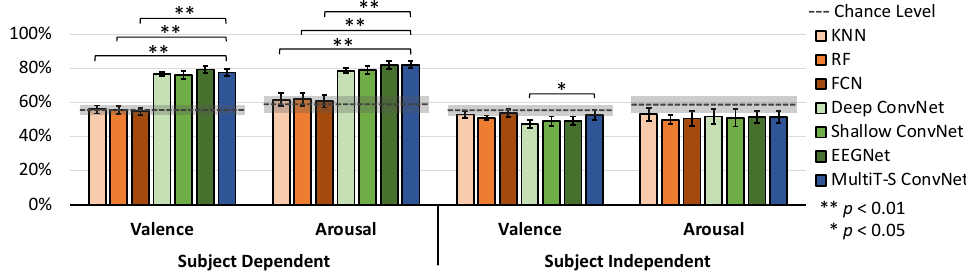
Figure 8. Average classification accuracy for all subjects on the DEAP dataset. Error bars denote a 95% CI computed from all subject’s means. The horizontal dashed lines indicate the chance level, and the grey areas indicate the CI of chance levels. The stars indicate significant differences compared with MultiT-S ConvNet.